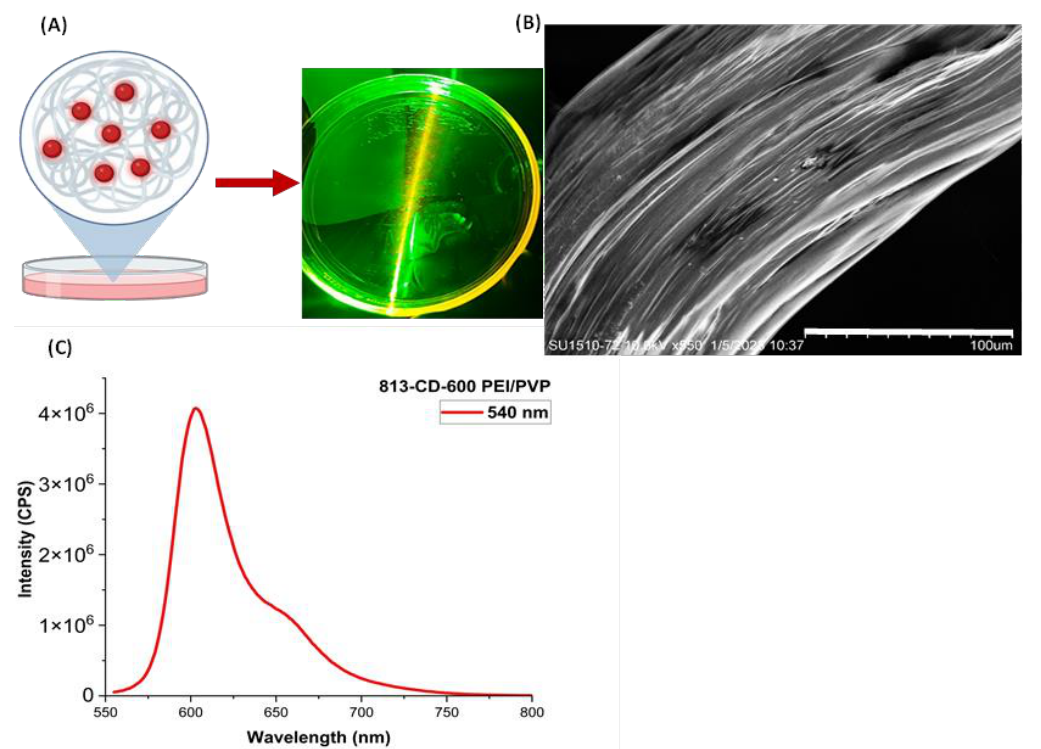
Figure 9. ( A ) Graphical representation and qualitative assessment of 813-CD/PVP nanocomposite thin films on a glass petri dish under 535 nm excitation. Created with BioRender.com, accessed